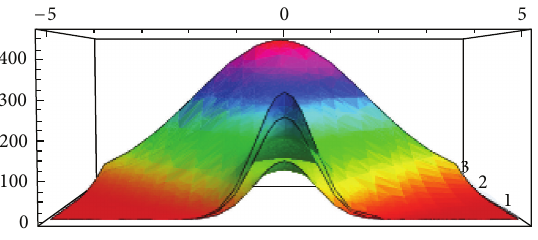
Figure 2: Graph of the fuzzy solution for 𝑎 = 0